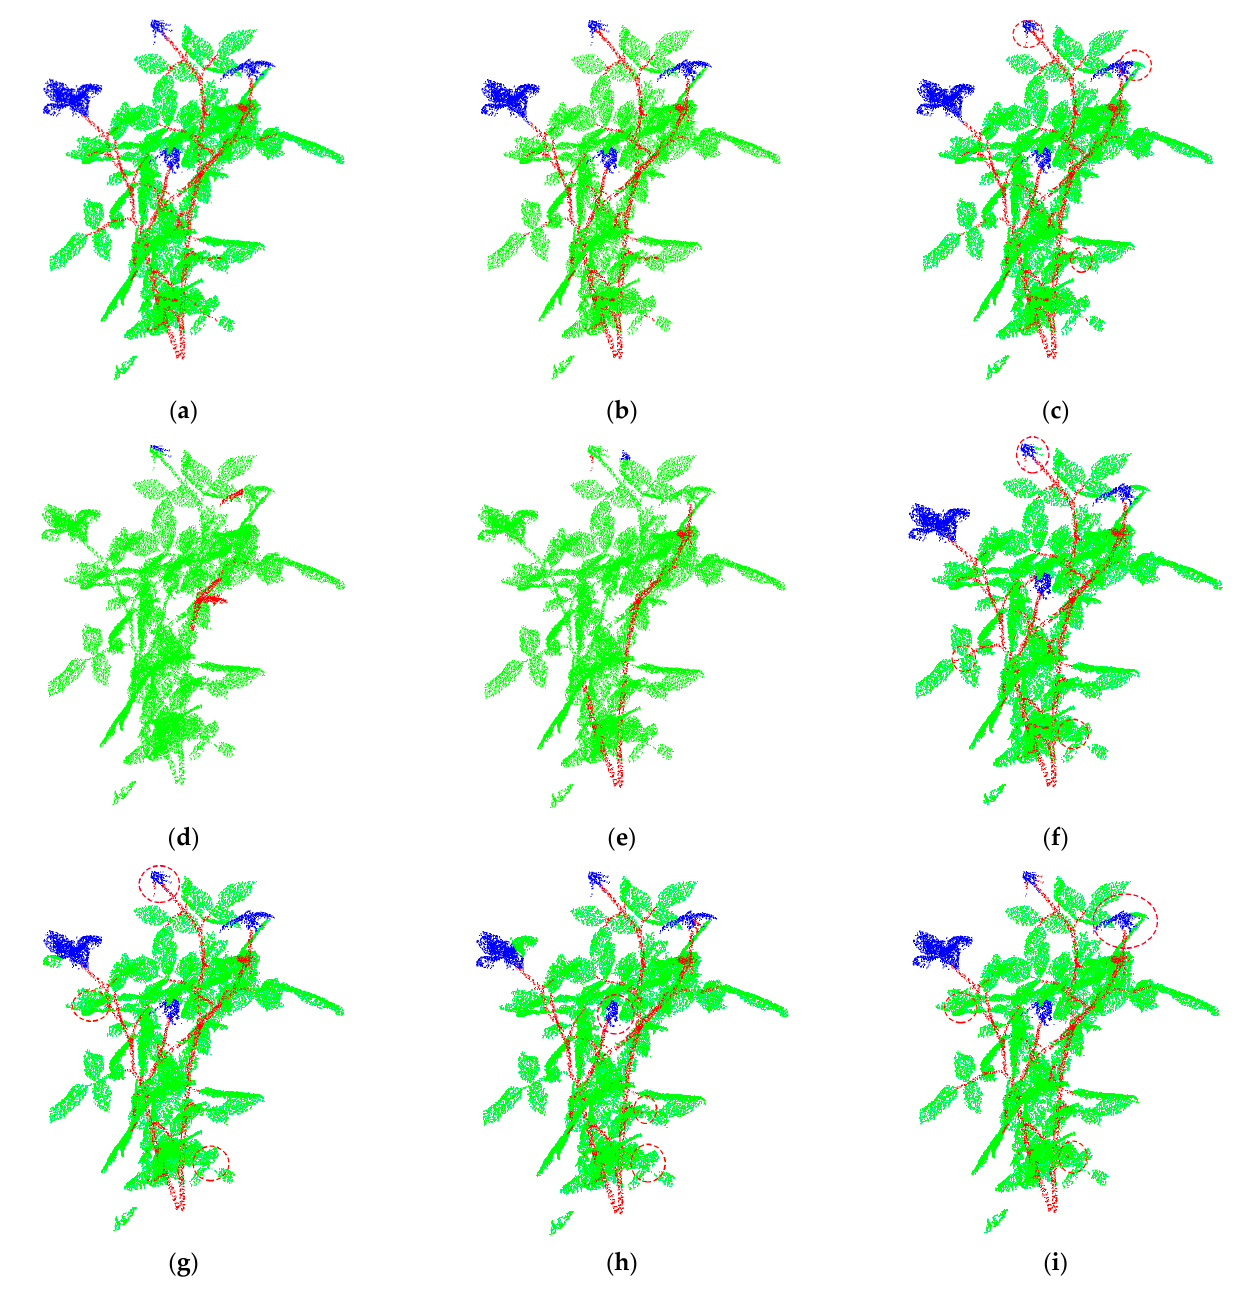
Figure 5. Segmentation result of each network on test_R1. ( a ) Ground Truth; ( b ) MASPC_Transform; ( c ) Point Transformer; ( d ) PointNet; ( e ) PointNet++; ( f ) DGCNN; ( g ) PointCNN; ( h ) ShellNet; ( i )